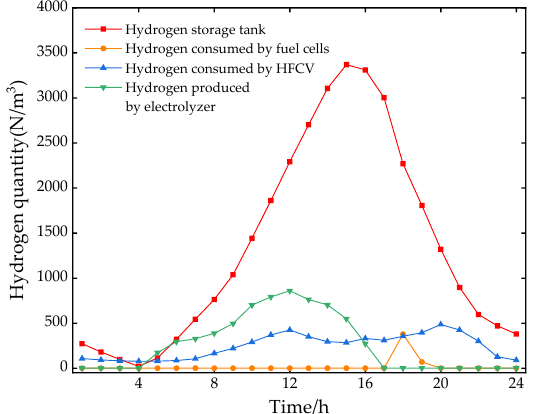
Figure 8. The hydrogen storage status of CES.